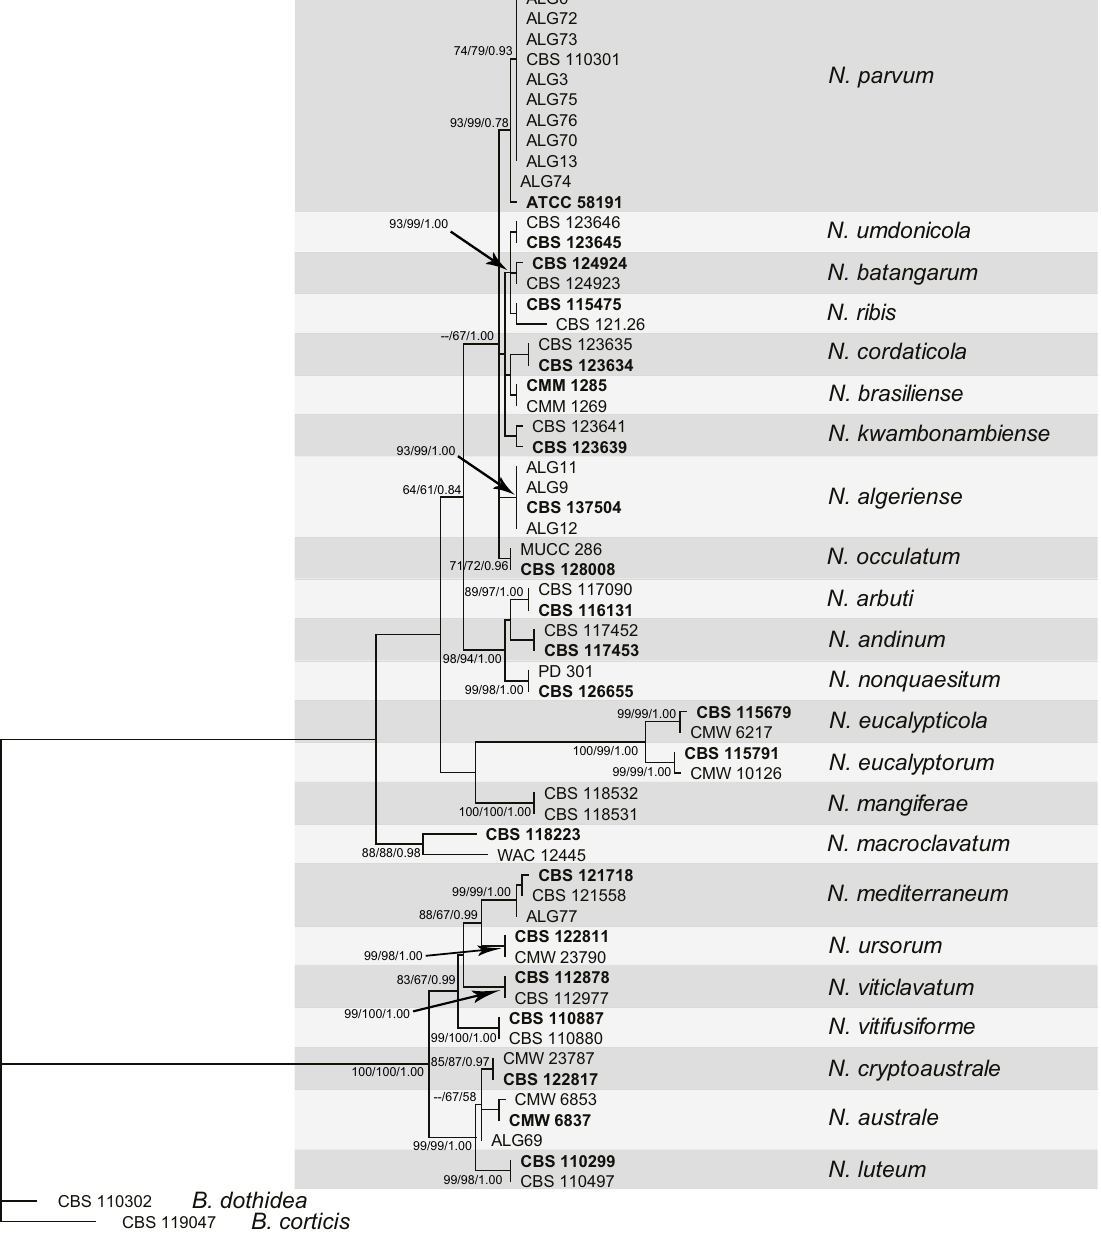
Figure 1. One of 209 equally parsimonious trees resulting from the alignment of 672 characters of combined ITS and EF-1α partial sequences. Length = 296; consistency index (CI) = 0. 774; retention index (RI) = 0.930; homoplasy index (HI) = 0.228. Ex-type isolates are given in bold typeface. Bootstrap values from 1000 replications are shown for Maximum Parsimony (MP), Neighbour-Joining (NJ) and Bayesian methods (BM) at the tree nodes (MP/NJ/BM). Branches marked with a minus (–) are not present in NJ tree. Botryosphaeria dothidea (CBS 110302; GenBank ITS: AY259092; TEF: AY573218) and Botryosphae- ria corticis (CBS 119047; GenBank ITS: DQ233245; TEF: EU01539) were included as